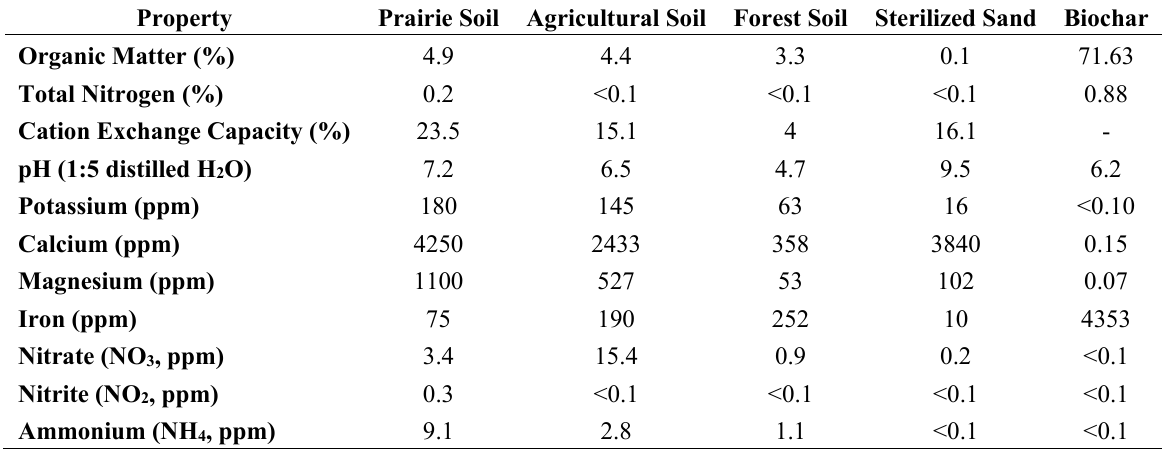
Table 1. Properties of the soils and biochar used in the experiments.